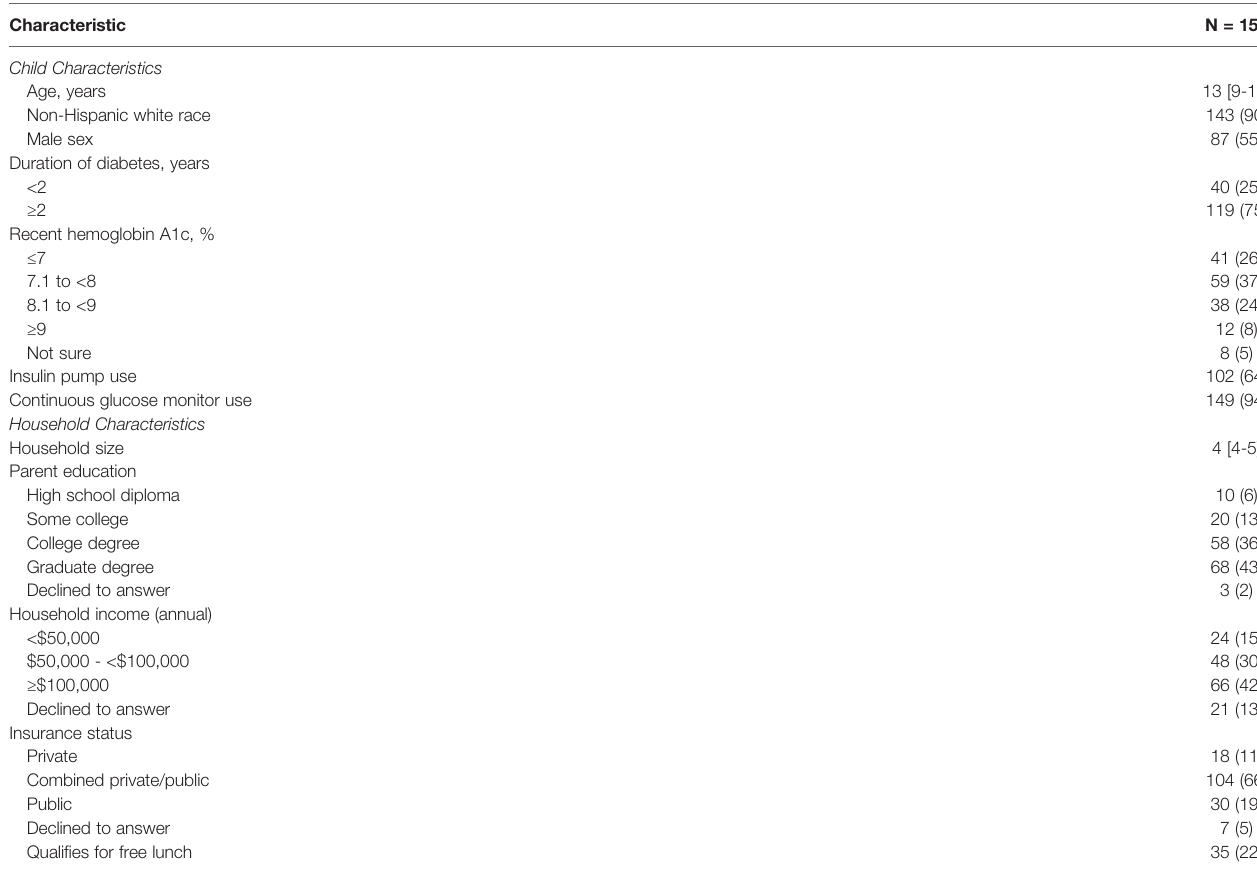
TABLE 1 | Child and household characteristics of survey